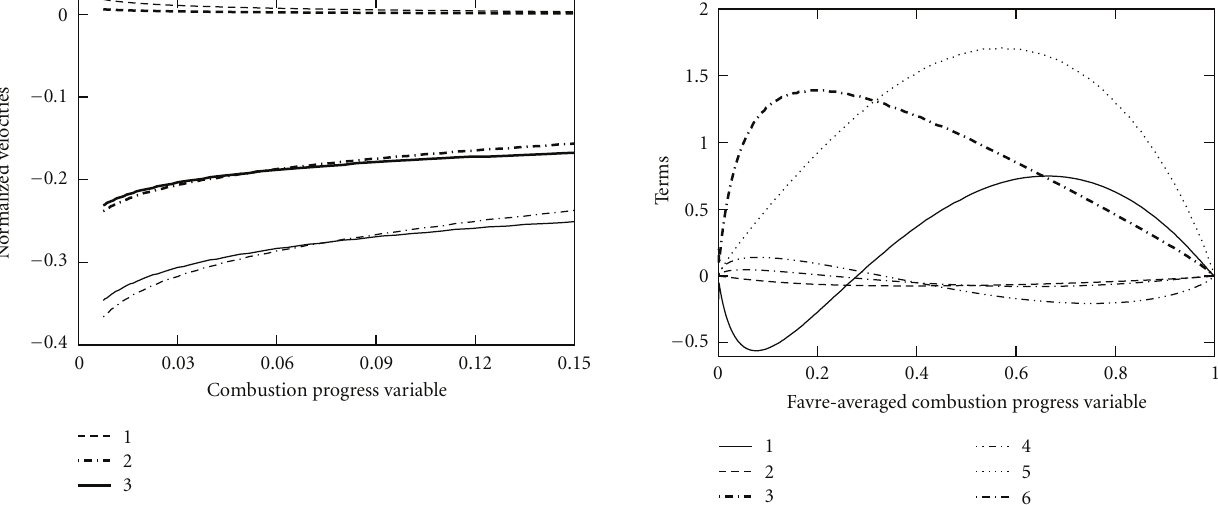
Figure 8: Di ff erent terms in (29), normalized using d and U , versus the Favre-averaged combustion progress variable. Curves have been computed in the flame h4 investigated by Li et al. [17]. Term numbers are specified in legends. Curve 6 shows the di ff erence between the LHS and RHS of